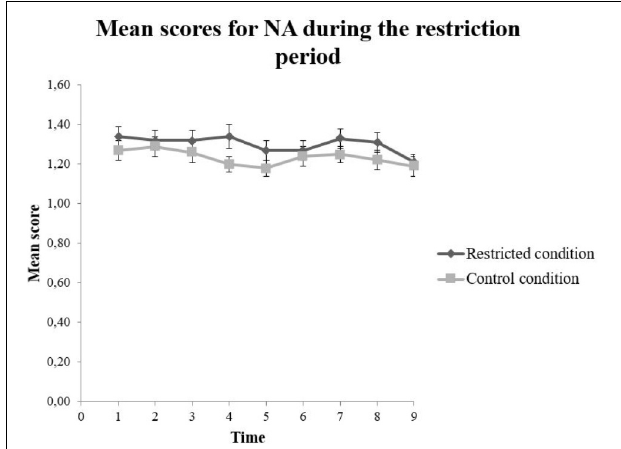
FIGURE 6 | Mean scores on Negative Affect (NA) for the restricted ( n = 67) and control ( n = 60) condition. The error bars represent standard error mean for each